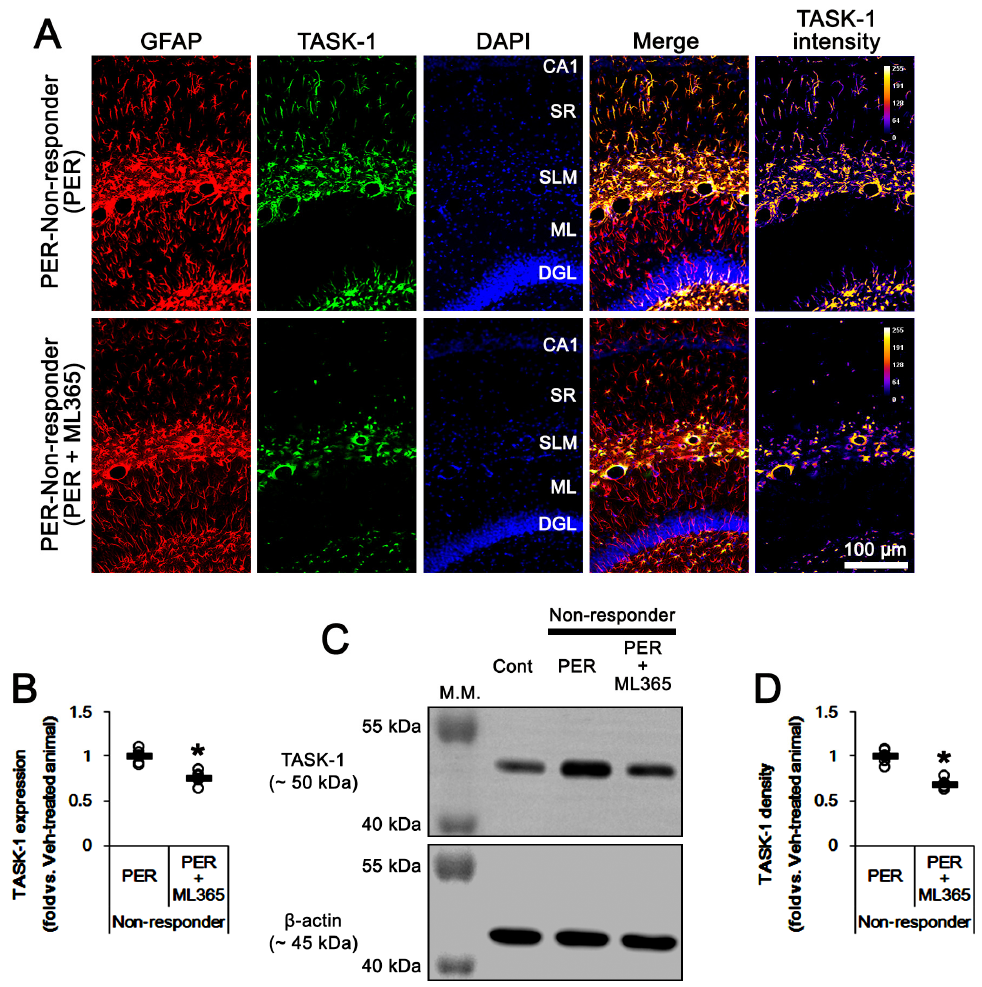
Figure 8. The effect of ML365 co-treatment with perampanel (PER) on TASK-1 expression in non-responders to PER. ML365 co-treatment reduces TASK-1 expression in CA1 astrocytes within the hippocampus of non-responders. ( A ) Representative photos of TASK-1 expression in the hippocam- pus (CA1, CA1 pyramidal cell layer; SR, stratum radiatum; SLM, stratum lacunosum-moleculare; ML, molecular layer of the dentate gyrus; DGL, dentate granule cell layer). ( B ) Quantitative analyses of the effect of ML365 co-treatment on TASK-1 expression based on immunofluorescence data. Open circles indicate each individual value. Horizontal bars indicate the mean value. Error bars indicate SEM (* p < 0.05 vs. perampanel-treated animals). ( C ) Representative Western blot images of TASK- 1 protein expression in the hippocampal tissues. ( D ) Quantifications of TASK-1 level based on West- ern blot (* p < 0.05 vs. perampanel-treated animals).